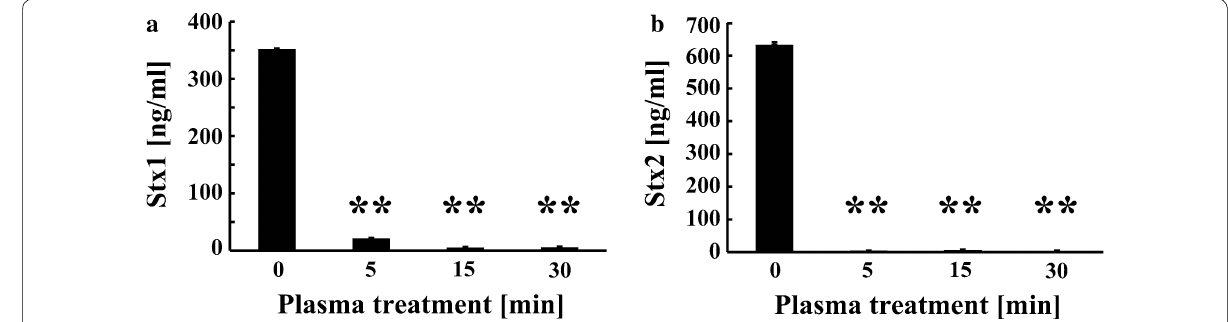
Fig. 2 Quantitative measurement of Stx1 and Stx2 by an enzyme-linked immunosorbent assay (ELISA) after nitrogen gas plasma treatment. A coverslip containing dried spots from 20 μl aliquots of a 1 μg/ml solution of Stx1 ( a ) and Stx2 ( b ) was treated with nitrogen gas plasma using BLP-TES device (1.5 kpps) for 0, 5, 15, and 30 min. The recovered samples were subjected to ELISA using RIDASCREEN ® Verotoxin (R-Biopharm AG, Darmstadt, Germany) to quantify Stx1 and Stx2. Values were considered significantly different from the untreated control (0 min) when verified by non-repeated measures ANOVA, followed by the Bonferroni correction (** p < 0.01)